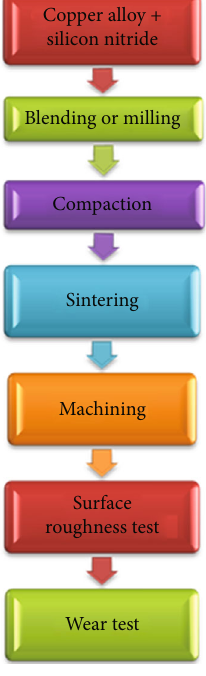
Table 1: Chemical composition of copper